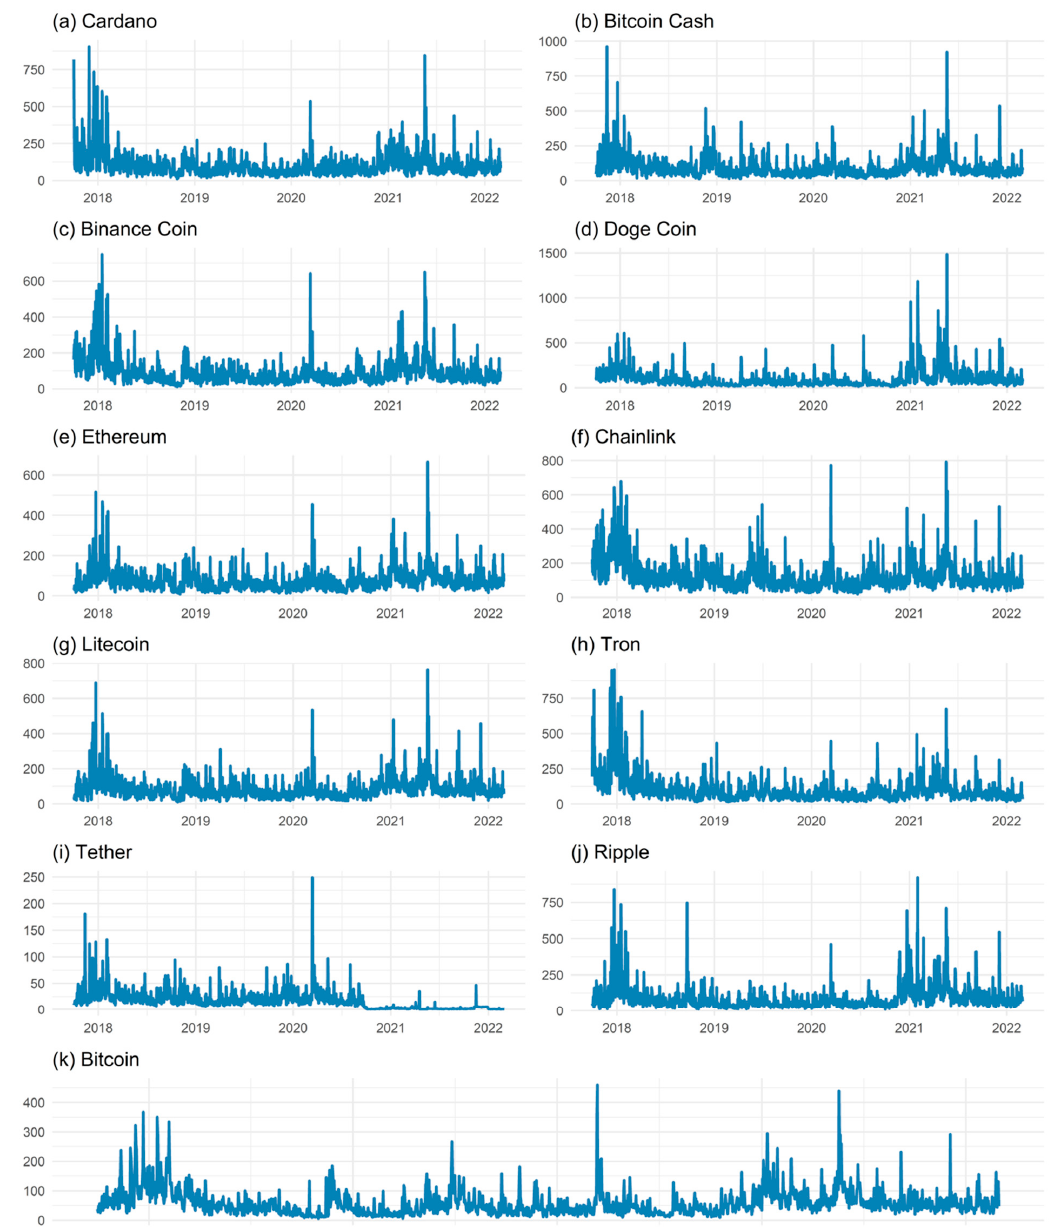
Figure 1. The plot of cryptocurrency volatility series.